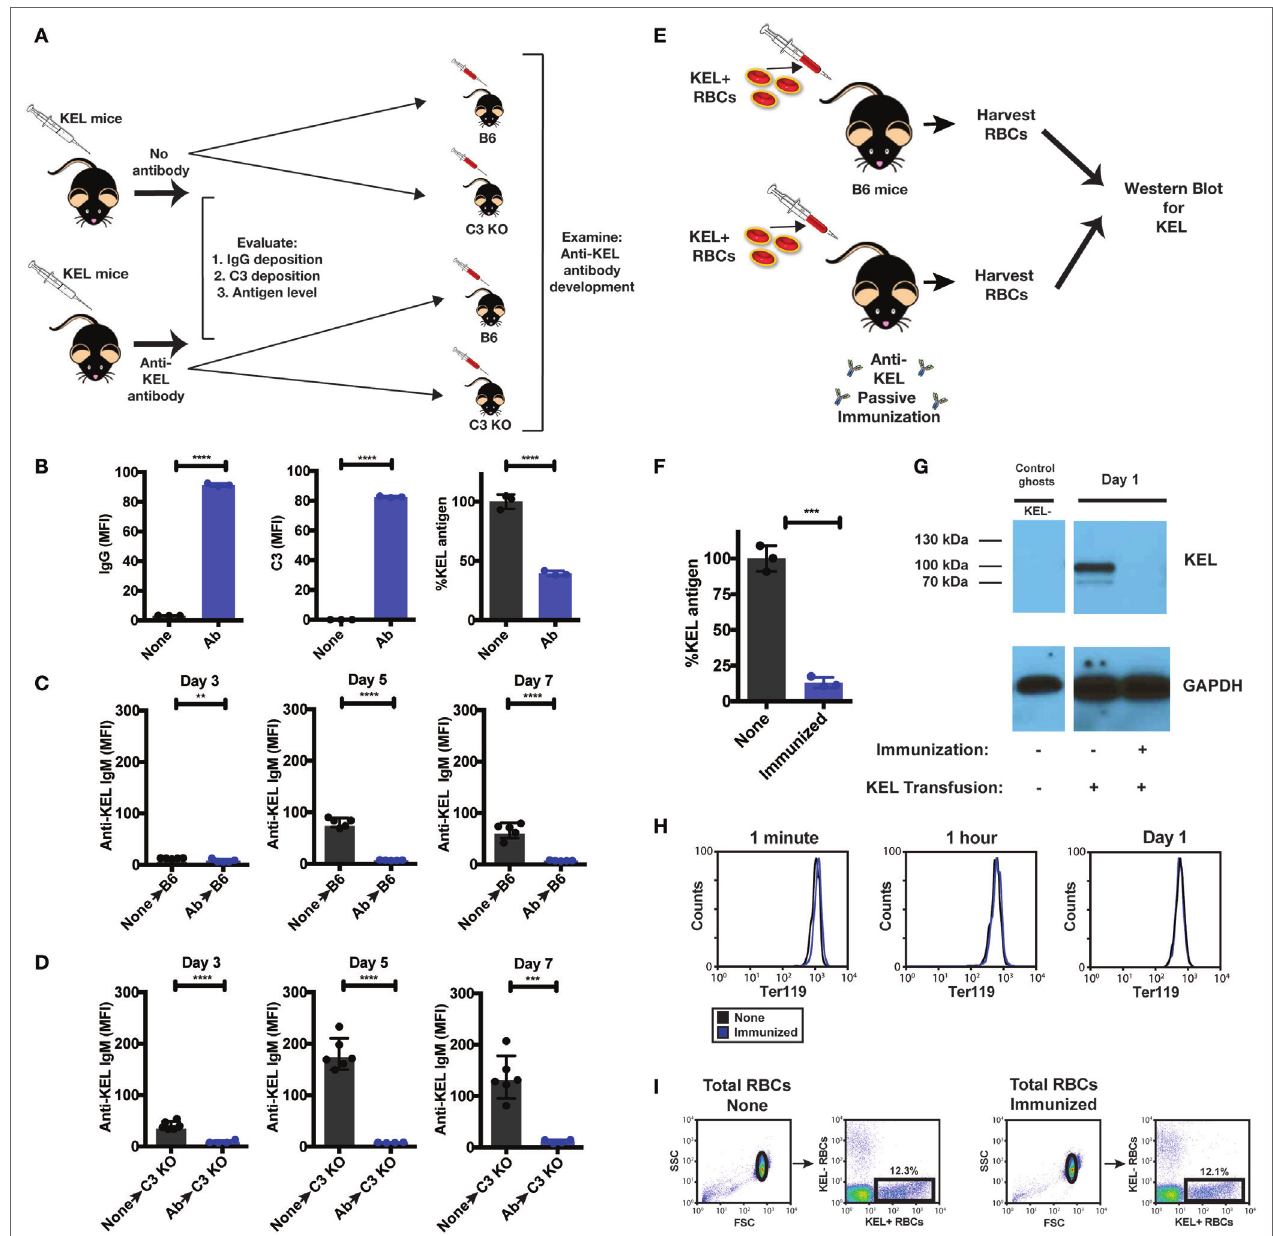
FigUre 9 | Re-transfusion of anti-KEL polyclonal antibody (Ab) treated KEL red blood cells (RBCs) into B6 or complement component 3 (C3) KO mice results in reduced anti-KEL Ab formation. (a) Schematic overview: anti-KEL polyclonal Ab or phosphate-buffered saline (PBS) (none) was injected into KEL donors, followed by initial evaluation for IgG deposition, C3 deposition, and KEL antigen levels. These isolated RBCs were then retransfused into B6 or C3 KO recipients, which were subsequently evaluated for anti-KEL Ab formation. (B) Following injection, IgG, C3, and detectable KEL antigen were assessed on transfused KEL RBCs in KEL donors. (c,D) KEL RBCs from PBS (none) or anti-KEL Ab-treated (Ab) KEL donors were harvested, followed by transfusion into KEL-negative naïve B6 (c) or C3 KO recipients (D) and assessed for anti-KEL IgM Abs on days 3, 5, and 7 post-transfusion. (e) Schematic overview: KEL-negative B6 mice were exposed to KEL RBCs in the absence (none) or presence of polyclonal anti-KEL Ab (immunized) at a volume adjusted ratio to ensure equivalent KEL RBCs were present in each group 1 day following transfusion. Day 1 post-transfusion, the level of detectable KEL antigen was measured by flow cytometry and western blot analysis. (F,g) Day 1 post-transfusion, the level of detectable KEL antigen was measured by flow cytometry (F) or western blot analysis (g) . (h) The level of KEL RBC Ter119 expression was assessed specifically on DiI-labeled transfused KEL positive RBCs at 1 min, 1 h, and Day 1 post-transfusion in immunized and non-immunized B6 mice by flow cytometry. (i) Gating strategy shows KEL RBC population in the absence (None) or presence of polyclonal anti-KEL Ab (Immunized). (B–F) ** p < 0.009, *** p < 0.0004 and **** p < 0.0001. Means ± SD